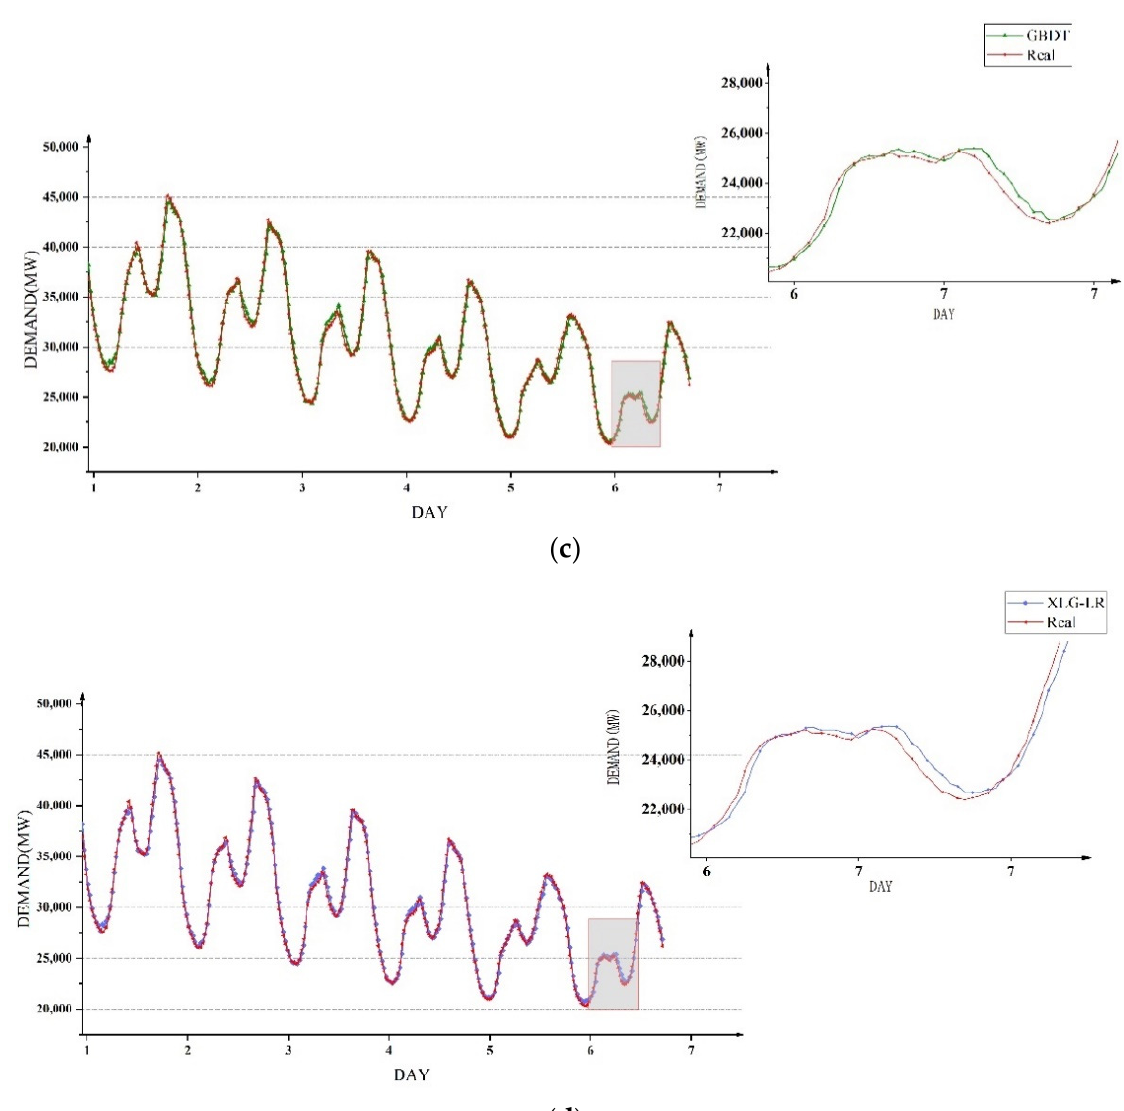
Figure 8. Power Demand Forecasting Results on a Weekly Basis. ( a ) XGB model; ( b ) LGB model; ( c ) GBDT model; ( d ) XLG-LR model. Table 4. Evaluation Index for Power Demand Forecasting of Each Model on a Weekly Basis.